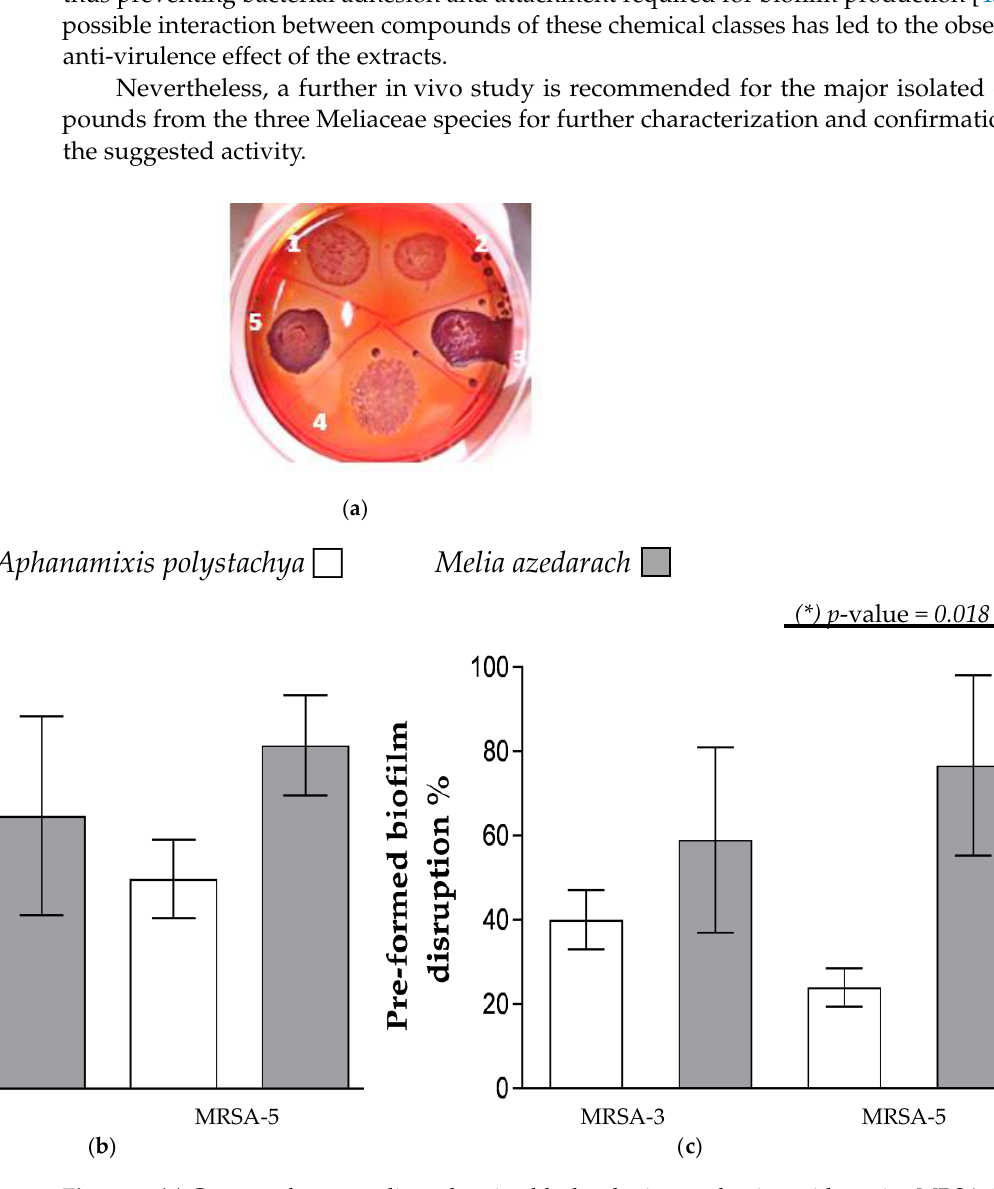
Figure 3. ( a ) Congo red agar medium showing black colonies production with strains MRSA-3 and MRSA-5 only, indicating positive slime production. Pink colonies indicate negative slime production. ( b ) Percentage inhibition of biofilm formation and ( c ) percentage disruption of preformed biofilm formed by MRSA-3 and -5 strains by Aphanamixis polystachya and Melia azedarach extracts at concentration of 0.125 mg.mL −1 . Data represent the means of percentage biofilm inhibition/disruption ± SD, n = 3 (one-way ANOVA, followed by Tukey’s multiple comparisons, p -value < 0.05). (*) Indicates presence of a statistically significant difference between columns.